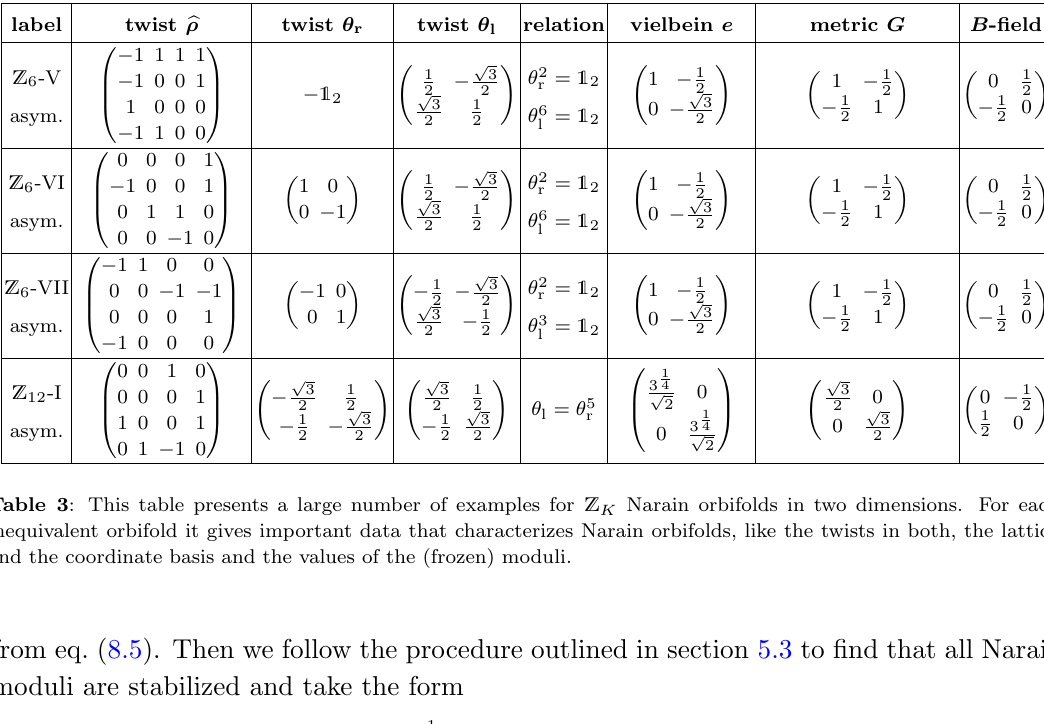
label twist b (cid:26) twist (cid:18) r twist (cid:18) l relation vielbein e metric G B -(cid:12)eld Z 6 -V asym.